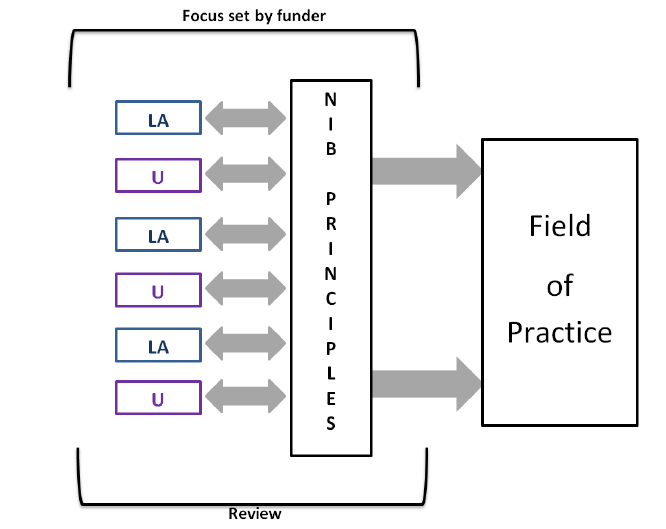
tention is upon a text (the NIB Principles) rather than between partners (as in Fig- ure 3). (LA = Local Authority; U =